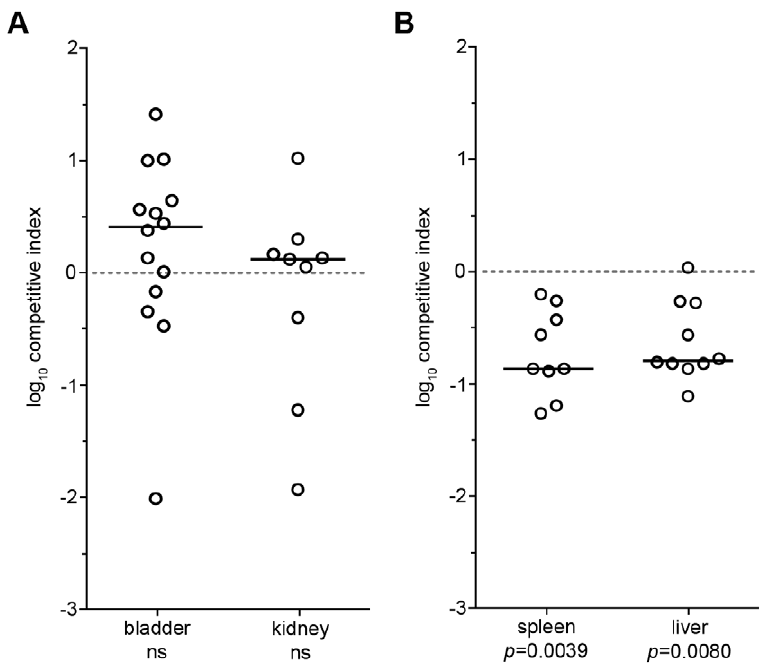
Figure 4. neaT enhances the fitness of CFT073 in a murine model of bacteremia. (A) Equal numbers (10 7 CFU total) of wild type CFT073 and CFT073 D neaT were transurethrally inoculated into the bladder of CBA/J female mice. Mice were sacrificed, organs harvested, and bacterial loads enumerated at 3 d post inoculation. (B) Equal numbers (10 6 CFU total) of wild type and CFT073 D neaT were inoculated into the bloodstream of CBA/J female mice via tail vein injection and bacterial titers present in the spleen and liver were enumerated 24 h later. Data are shown as competitive indices, where negative values indicate a reduction in the fitness of CFT073 D neaT . Bars indicate median values for each group; n $ 9 mice. P values determined using Wilcoxon-matched paired signed rank; ns=not significant.